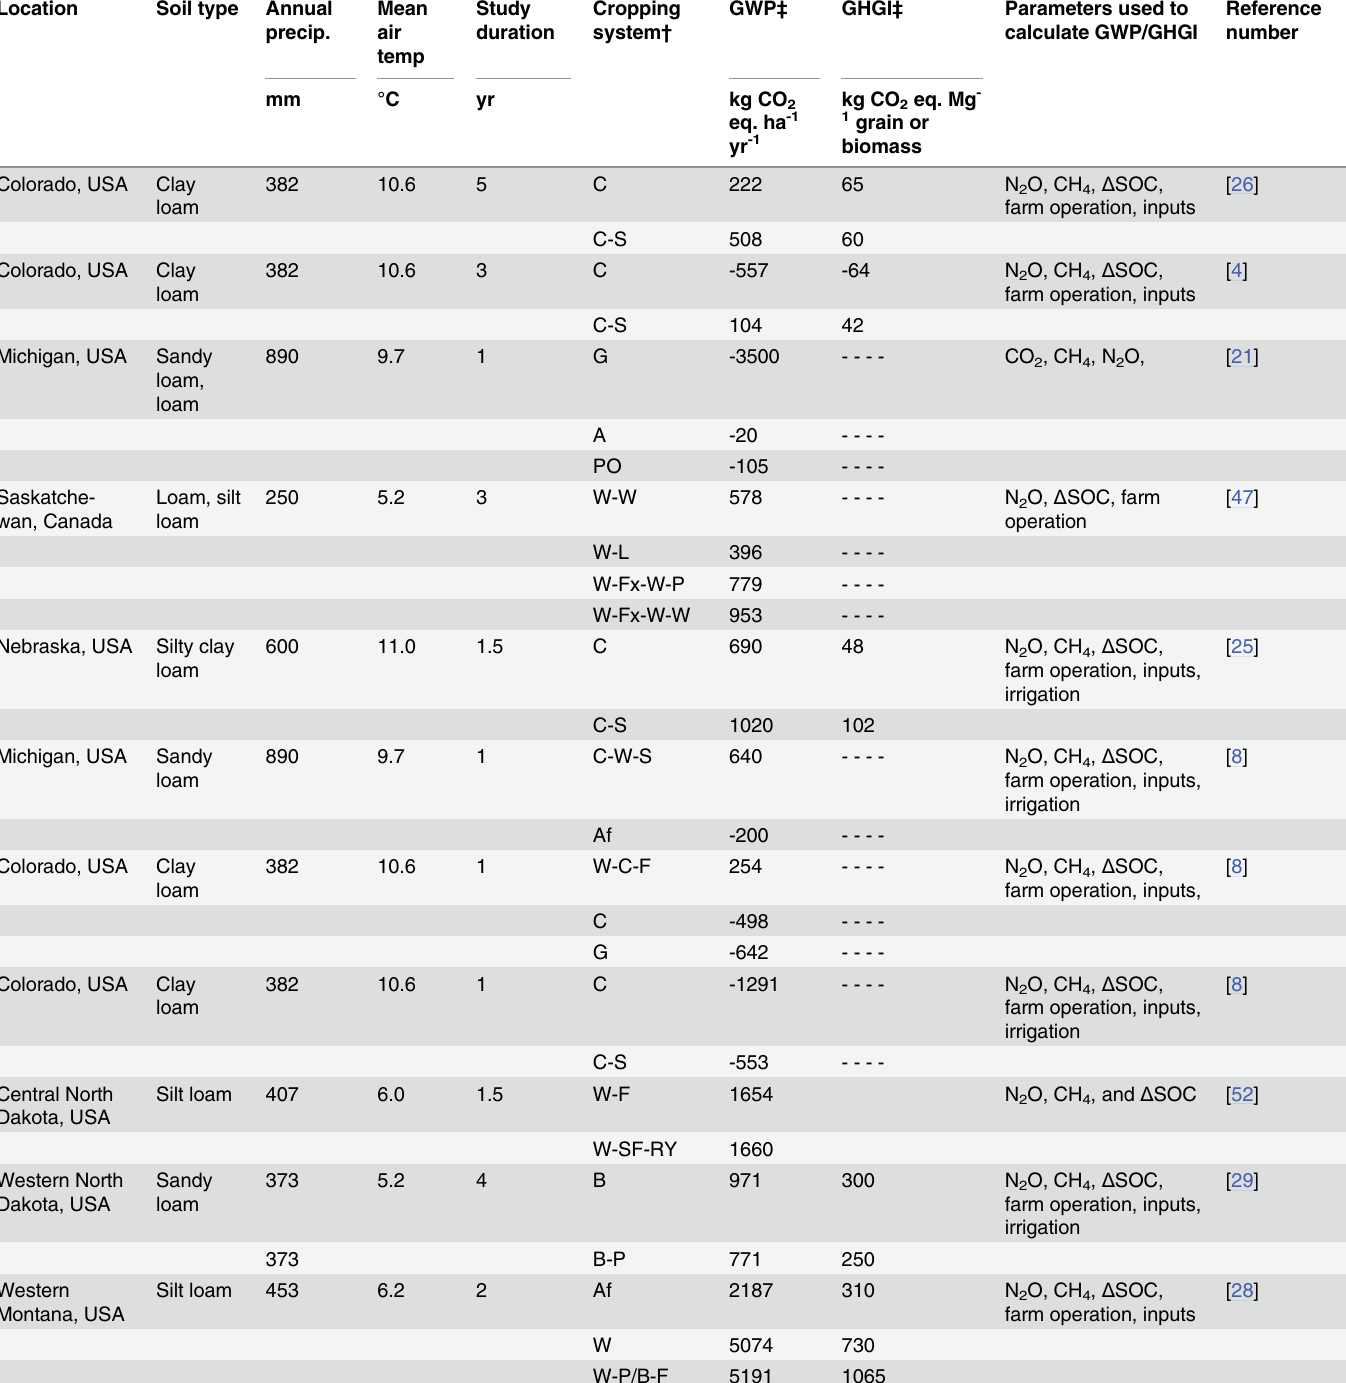
Table 2. Effect of cropping systems on net global warming potential (GWP) and greenhouse gas intensity (GHGI) calculated by using the soil organic C method in various regions with different soil and climatic conditions. Location